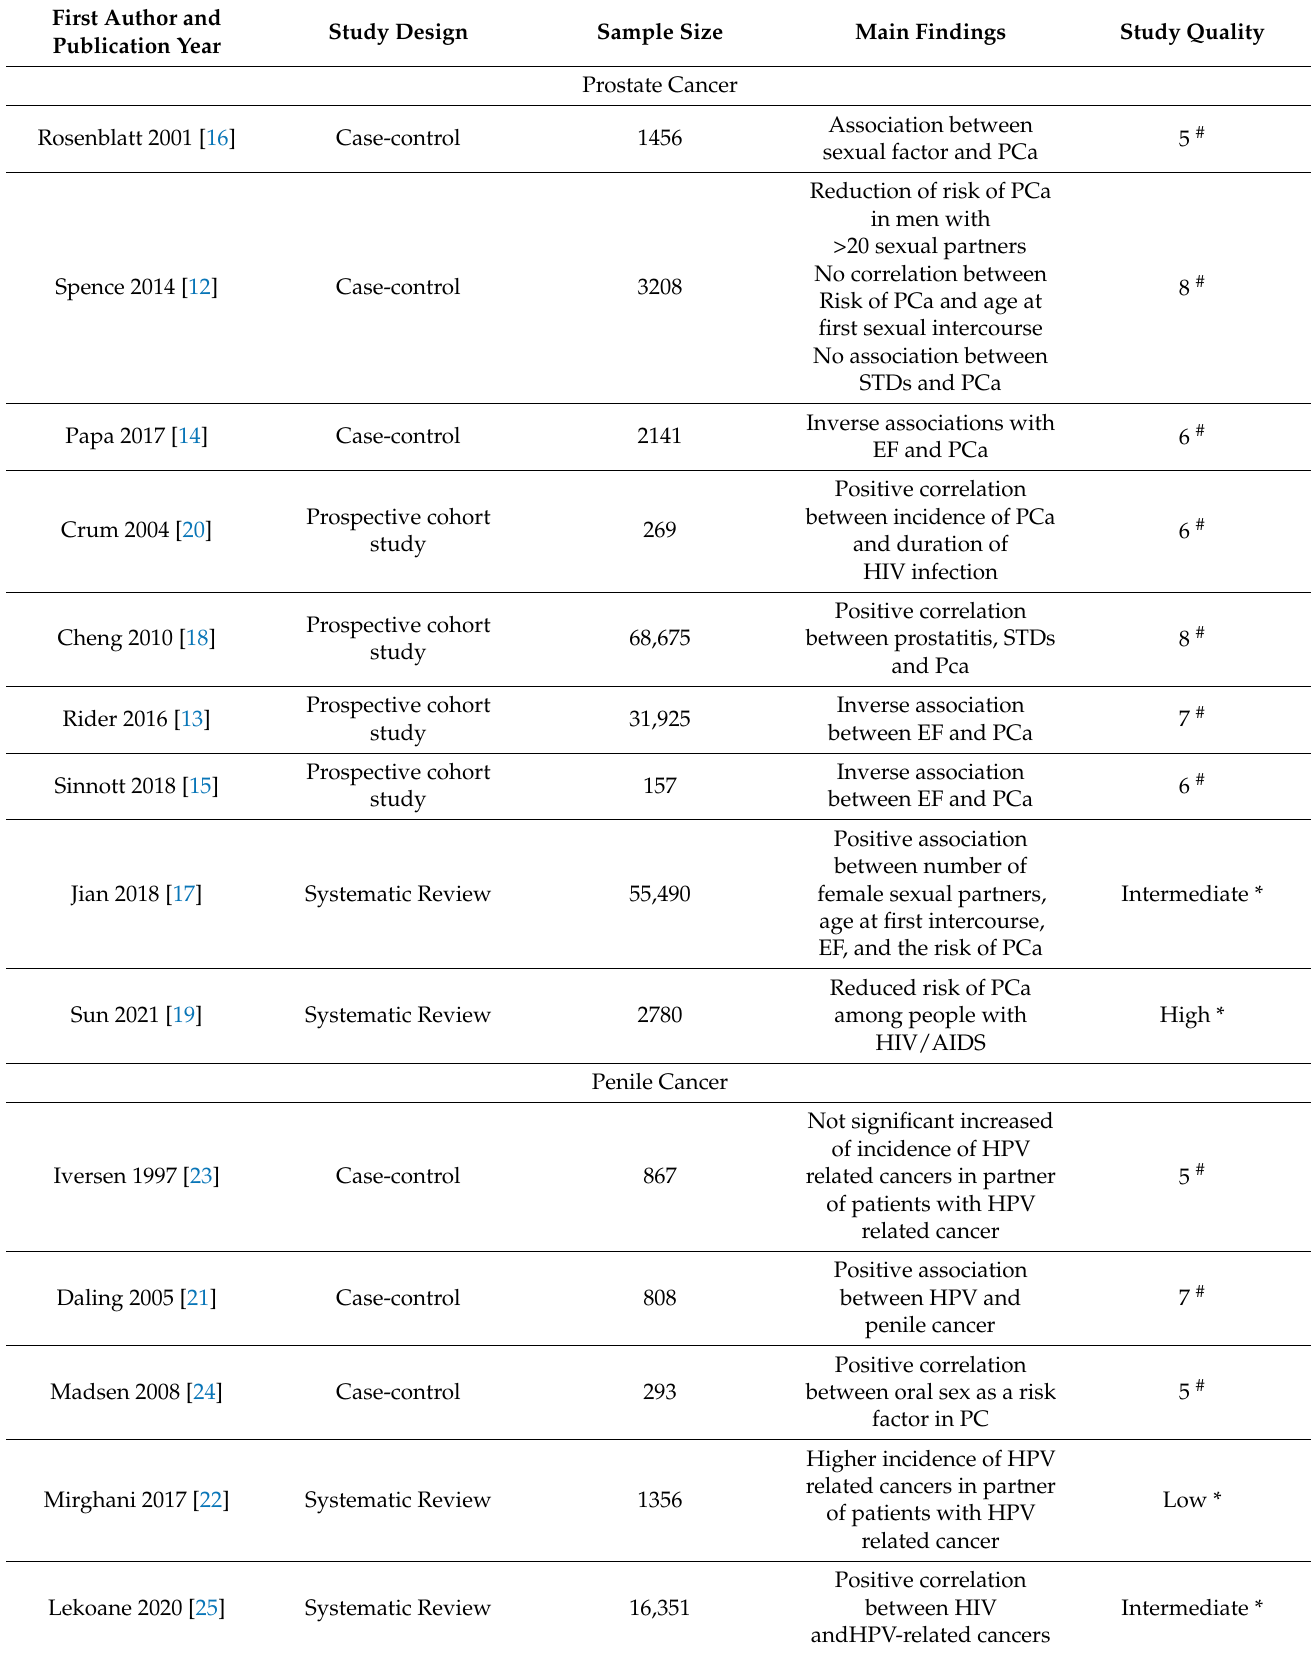
Table 1. Main characteristics of the selected